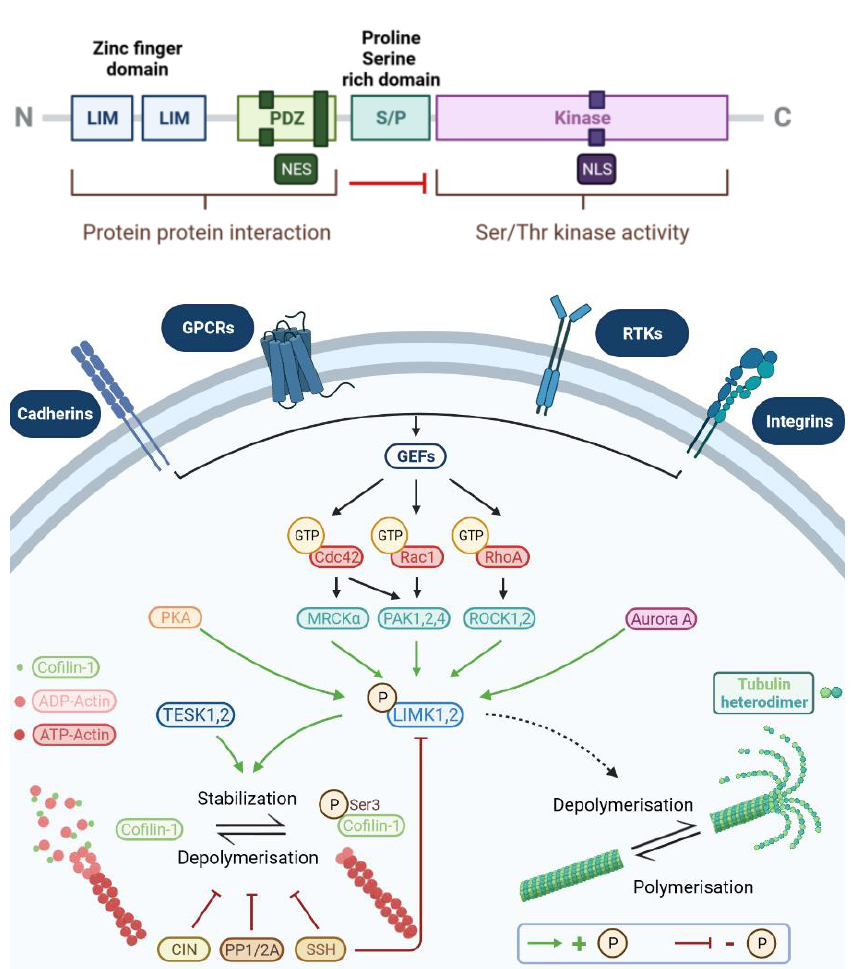
Figure 1. The LIMK family: (Upper panel) Protein organization of LIM kinases. Blue represents the LIM domains, green represents the PDZ domain, blue/green represents the S/P domain, and pink represents the kinase. (Lower panel) Activation of LIMKs. LIMKs are phosphorylated by the RhoA/ROCK1,2, Rac1/PAK1,2,4, Cdc42/MRCKα, or Cdc42/PAK1,2,4 pathways upon stimuli. LIMK1/2 regulate cofilin activity by its phosphorylation. Cofilin binds preferentially to actin-ADP, stimulates actin cleavage and depolymerization, and promotes actin filament turnover. Cofilin is inactivated by LIMK through the phosphorylation of a serine residue at position 3 (Ser3). The activa- tion of cofilin by dephosphorylation is mainly achieved by phosphatases such as slingshots (SSH), chronophin (CIN), and phosphatases 1 and 2A (PP1/2A). LIMKs also contribute to microtubules (MT)